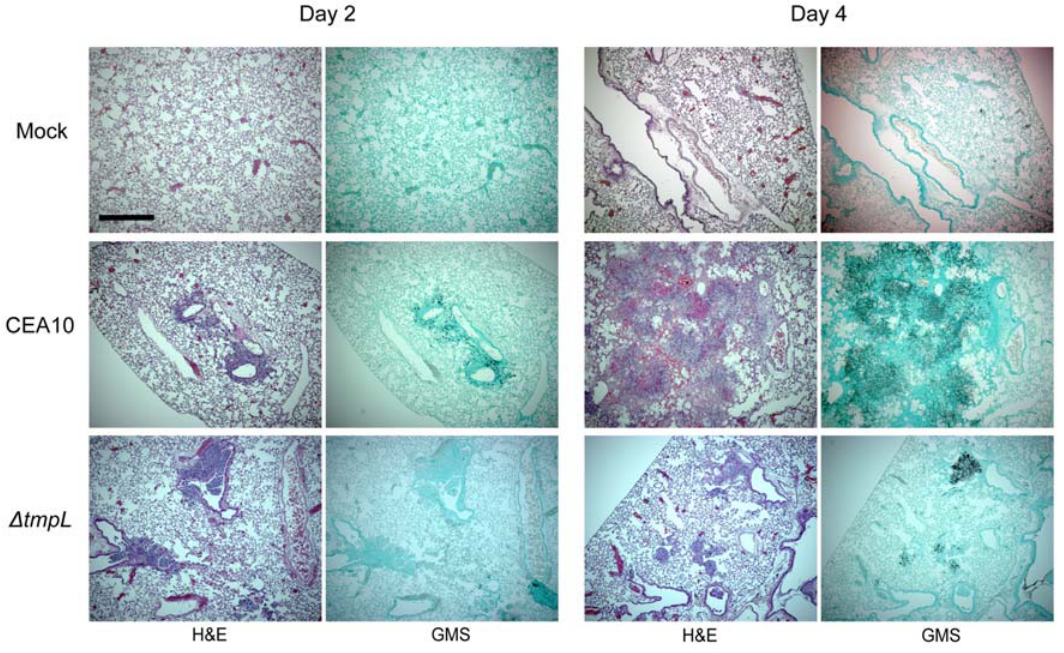
Figure 11. Representative histopathology of CD-1 mouse model infected with A. fumigatus wild-type and D tmpL mutants. Mock=0.01% Tween inoculated, CEA10=WT, D tmpL = A. fumigatus D tmpL mutant. Mice were inoculated with 1 6 10 5 conidia intranasally, euthanized on days + 2 and + 4 after inoculation, lungs removed, fixed in formaldehyde, and stained with hematoxylin and eosin (H&E) or Gommori’s methenamine silver (GMS) stain. On day + 2, Af D tmpL mice generally displayed less necrotic lesions and less fungal burden as the wild-type. Significant inflammation, necrosis, and an influx of immune effector cells (primarily neutrophils) were observed on day + 4 in all infected animals but not the mock control. However, lesions are more localized and not as extensive and we clearly observed more open alveoli in mice infected with the Af D tmpL strain. Interestingly, GMS staining revealed that fungal growth is less extensive in the Af D tmpL strain as well. Bar=500 m m at 40 6